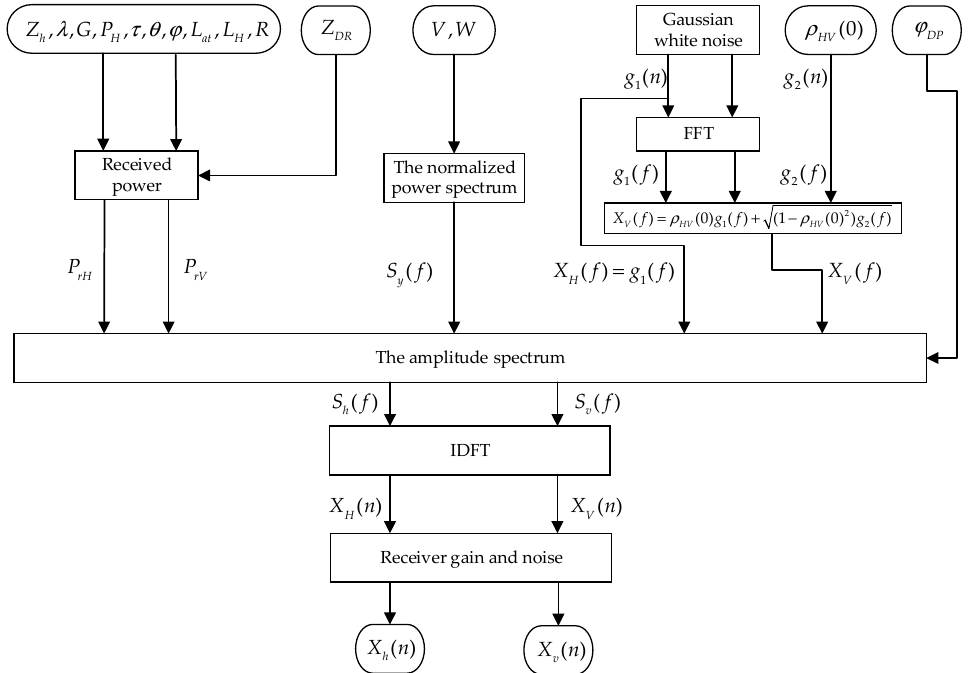
Figure 1. Flow chart of echo signal simulation formula of dual-polarization weather radar.